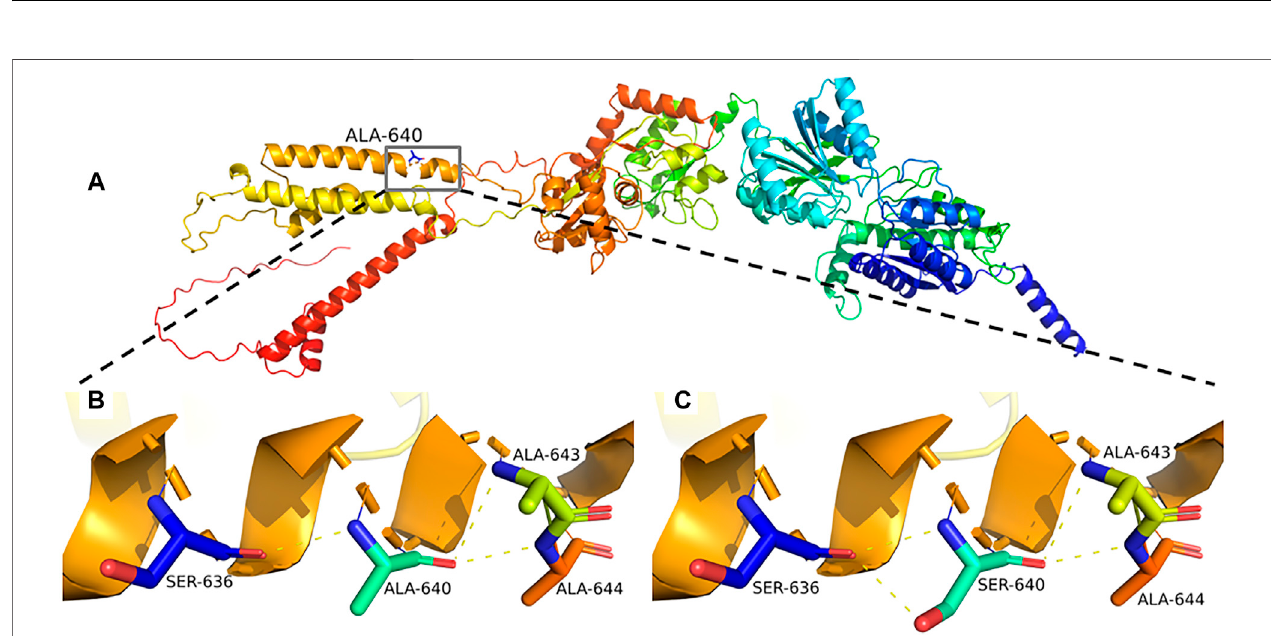
FIGURE 3 | (A – C) Predicted mutational impact of p.Ala640Ser on the GRIA4 protein structure. Compared to the WT model (B) , the new hydrogen bond formed between the mutant Ser640 (C) and the neighboring Ser636 hydrogen bonds, yellow dashed lines.